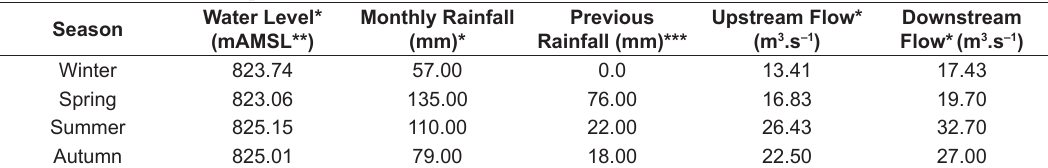
Table 1. Data of Itupararanga Reservoir in different seasons (Winter-August/2009; Spring-October/2009; Summer- February/2010;